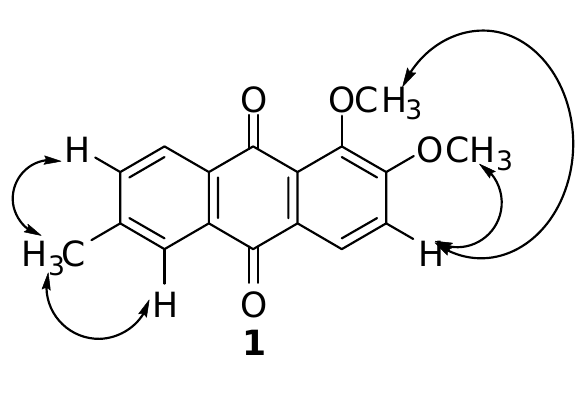
Figure 2. NOESY Correlations of 1